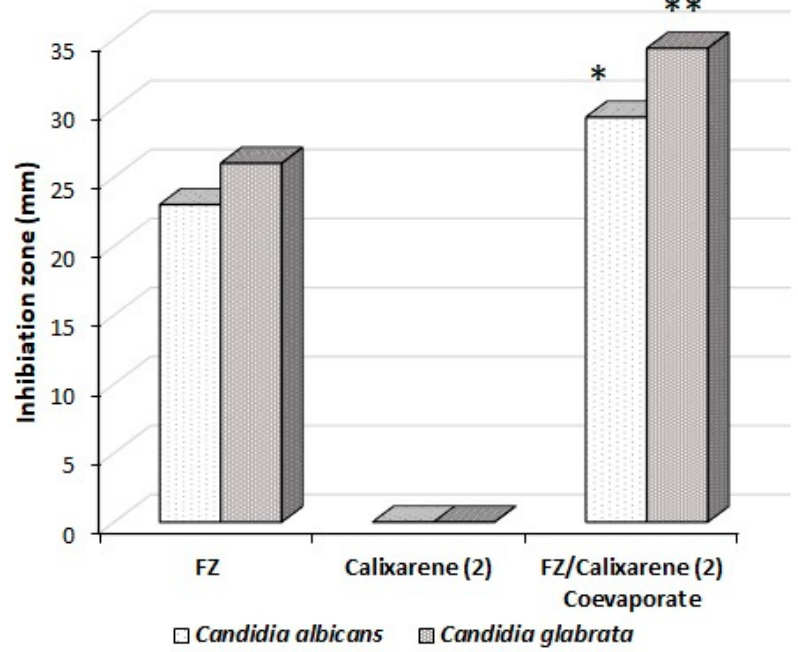
Figure 8. The antimycotic activity of pure FZ, sulfonatocalix[4]naphthalene, and co-evaporate inclusion complex of FZ-sulfonatocalix[4]naphthalene (conc.; 6 mM) against pathogenic clinical strains of Candida albicans and Candida glabrata . Inhibition zones were measured in mm. * FZ/co-evaporate significantly ( p ≤ 0.05; t -test) active against Candida albicans than pure FZ; ** FZ/co-evaporate significantly ( p ≤ 0.05; t -test) active against Candida glabrata than pure FZ; ( n = 3, ±S.D.).